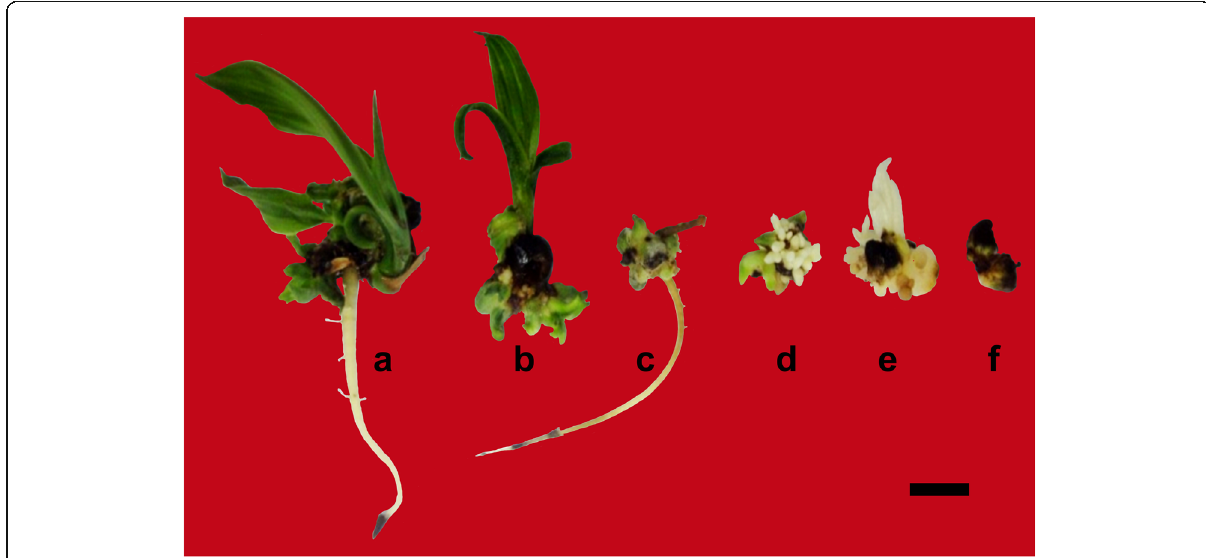
Fig. 1 Influence of different gelling agents (supplemented in MS medium) on conversion and morphological characteristics of oil palm polyembryoids. a Induced multiple shoots with root in 3.5 g/l Gelrite®. b Induced shoots (only) in 8 g/l Agar Type 900. c Induced root (only) in 12 g/l Agar Type 900. d Induced secondary somatic embryos in 1.5 g/l Gelrite®. e Induced callus in 2.5 g/l Gelrite®. f Dead (degenerated) polyembryoid in 10 g/l Agar Type 900 (bar = 5